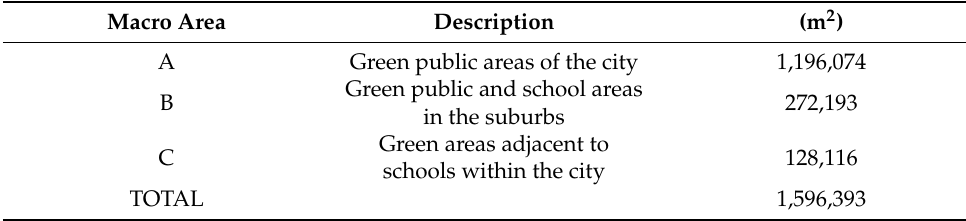
Table 5. Extension of the green heritage of the Municipality of Latina.